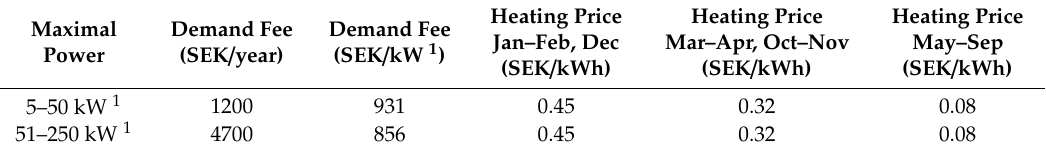
Table 12. Cost of district heating in Linköping,